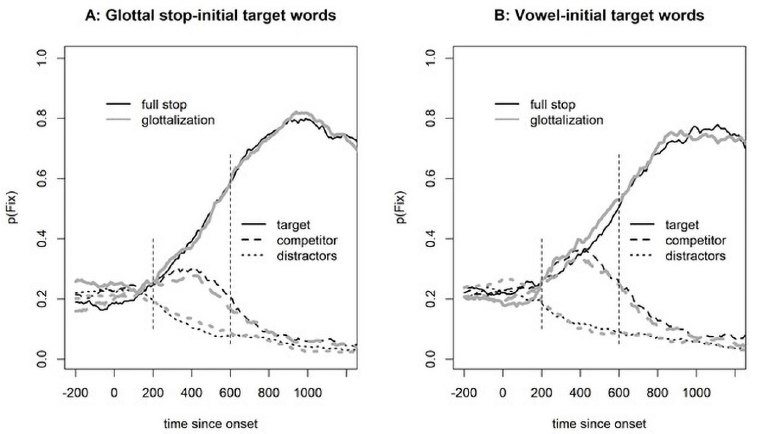
Fig 2. Fixation proportions in Experiment 1. Note that the vertical dotted lines indicate the analysis window, 200– 600 ms after target-word onset.